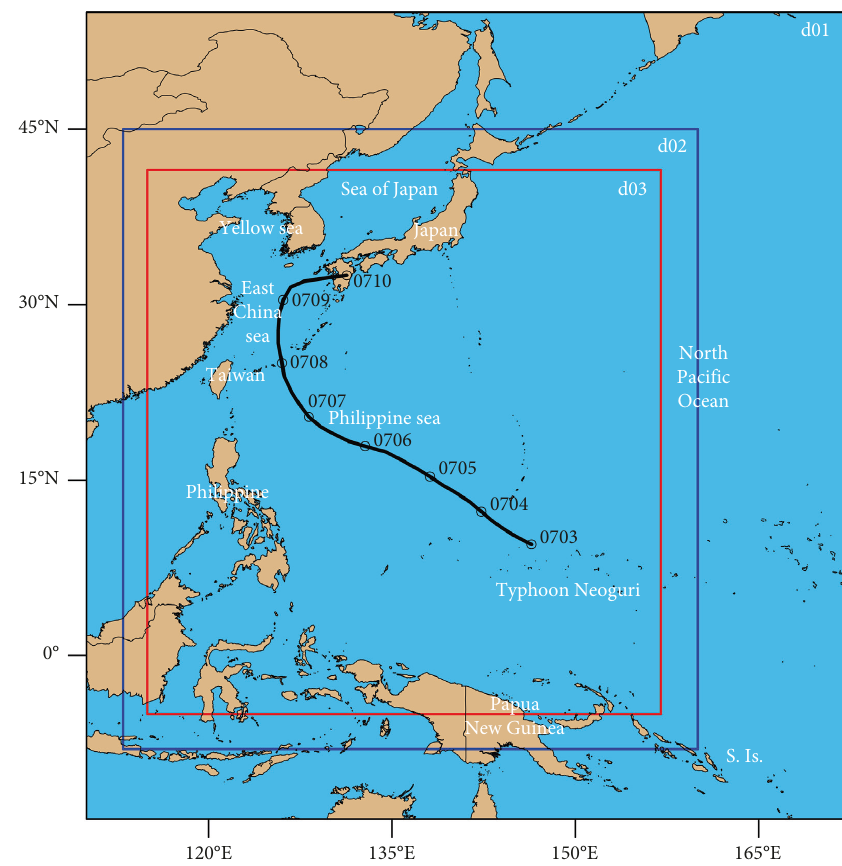
Figure 1: Three two-way nested domains used for numerical simulations of supertyphoon Neoguri (2014) in WRF. Horizontal resolutions for domains d01, d02, and d03 are 36, 12, and 4km, respectively. The JTWC track of typhoon Neoguri also is